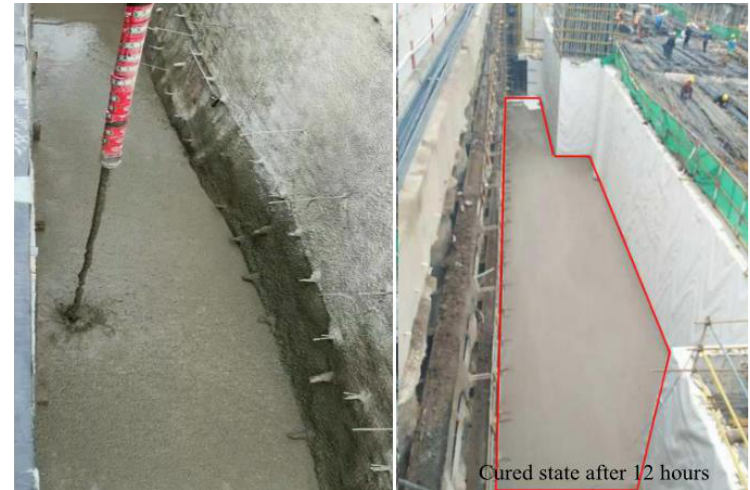
Figure 2. Casting and backfilling of composite-cemented soil.